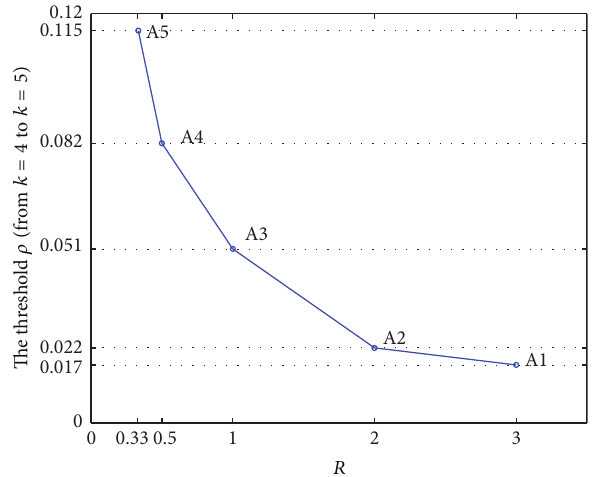
Figure 15: Curve of the thresholds of 𝜌 at which the optimal CODP changes from 𝑘 = 4 to 𝑘 = 5